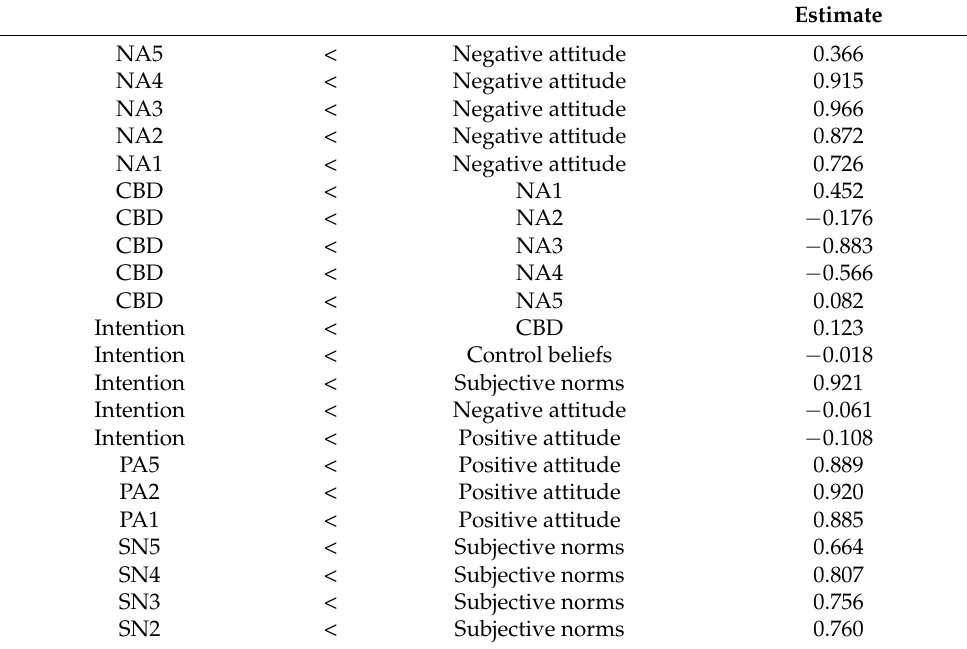
Figure 2. Intention to consume hemp food using the Theory of Planned Behaviour. Table 6. Standardized regression weights for intention to consume hemp